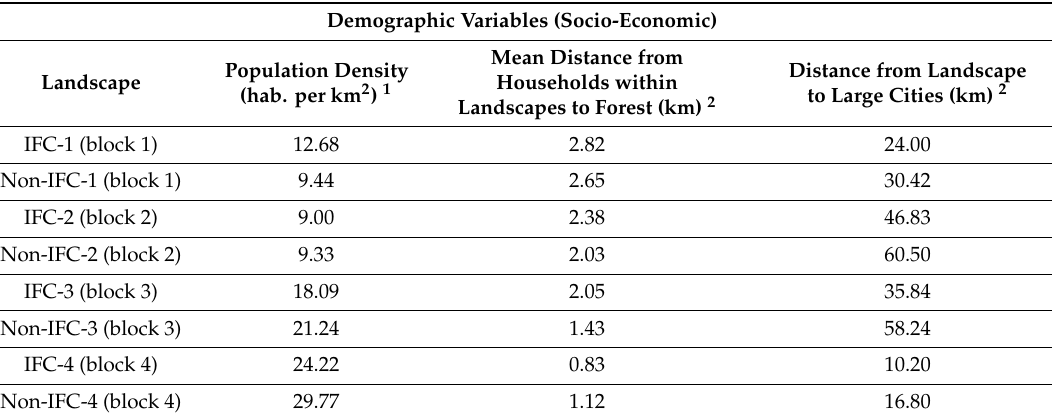
Table A2. Demographic variables considered for the block design.